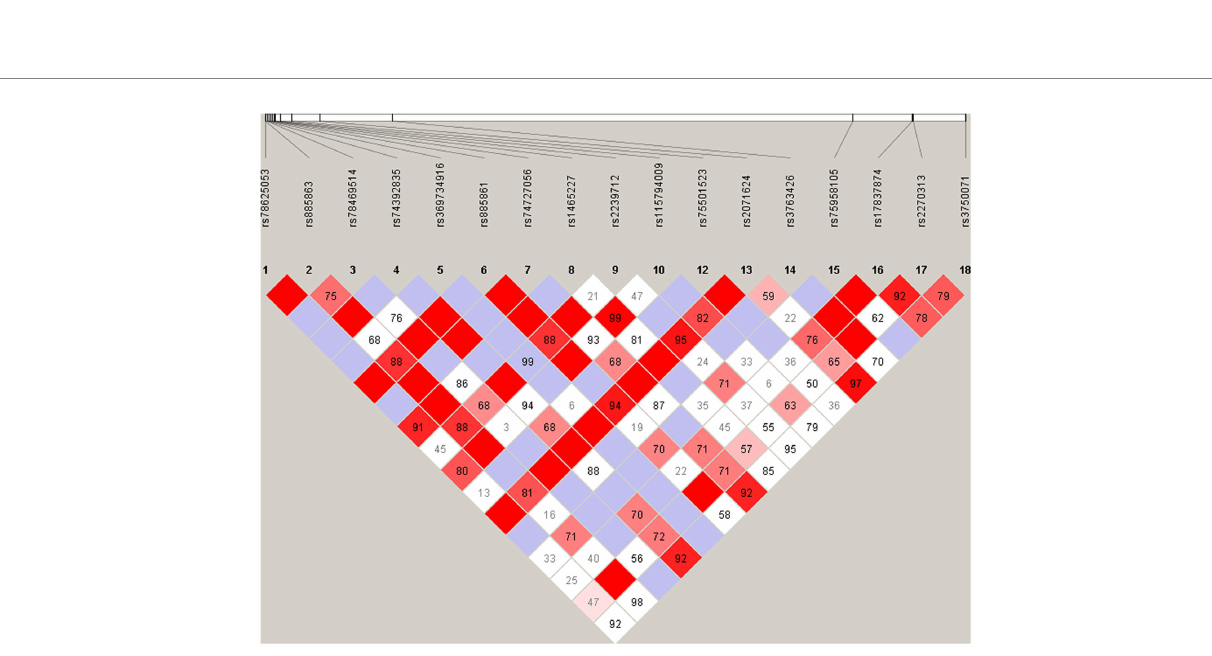
FIGURE 5 Pairwise linkage disequilibrium plot for the common variants in VIPR2 gene. The pairwise D ′ values are presented in the matrices, Deep red implicates relatively strong linkage disequilibrium, and vice